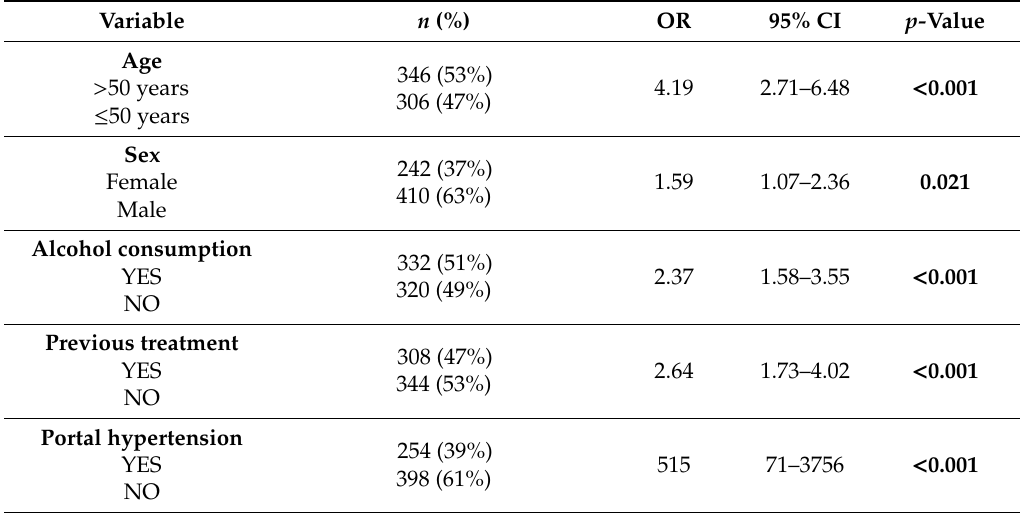
Table 2. Results of univariate analyses for liver cirrhosis risk in chronic hepatitis B